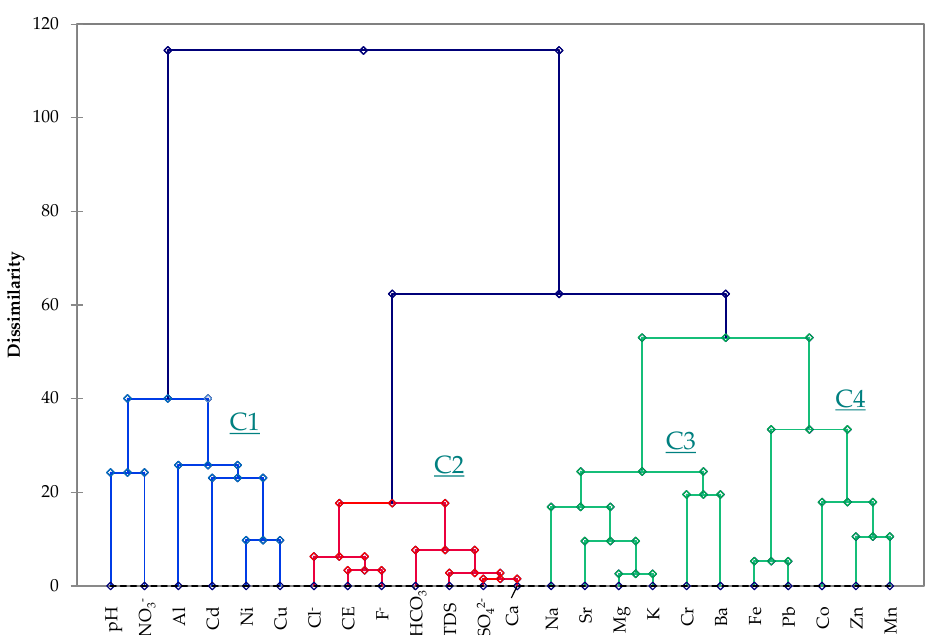
Figure 5. Hierarchical cluster analysis of the physico-chemical indicators for the studied samples. The water types of the analyzed samples were determined using the Piper and Du- rov diagrams(Figure 6a,b). The hydrochemical facies and different types of waters were assessed based on the major cations and anions projected into the diamond field situated in the center of the Piper plot [32,42]. In the cation plot, most of the studied water samples were situated in the left corner, where the Ca concentration was high, indicating its dominance. In contrast, the anion diagram showed that most of the water samples were distributed in the lower-left corner, characterized by the dominance of HCO 3− over Cl − and SO 42− . However, two samples were situated in the upper corner and dominated by SO 42− over Cl − and HCO 3− .